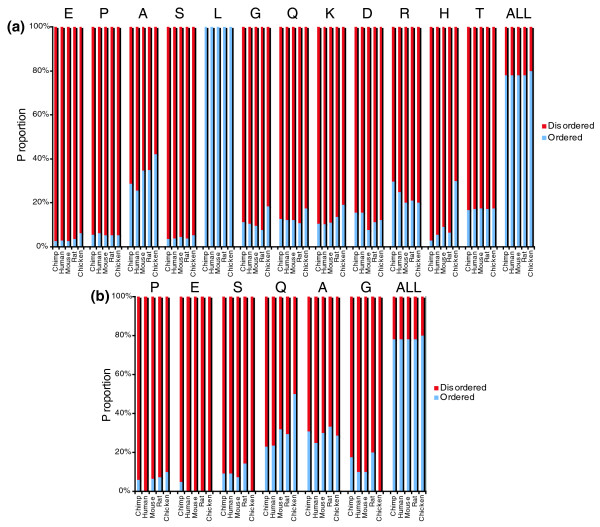
Proportions of AAR residues predicted to be ordered or disordered by RONN [39]. (a) tandem repeats; (b) C4 repeats. Ordered residues are shown in purple, disordered residues in red. Residues are ordered by frequency and frequencies for each proteome are presented in each group in the order: chimpanzee, human, mouse, rat, chicken. The section labeled 'ALL' in (a, b) shows the proportions of ordered and disordered amino acids in each proteome.